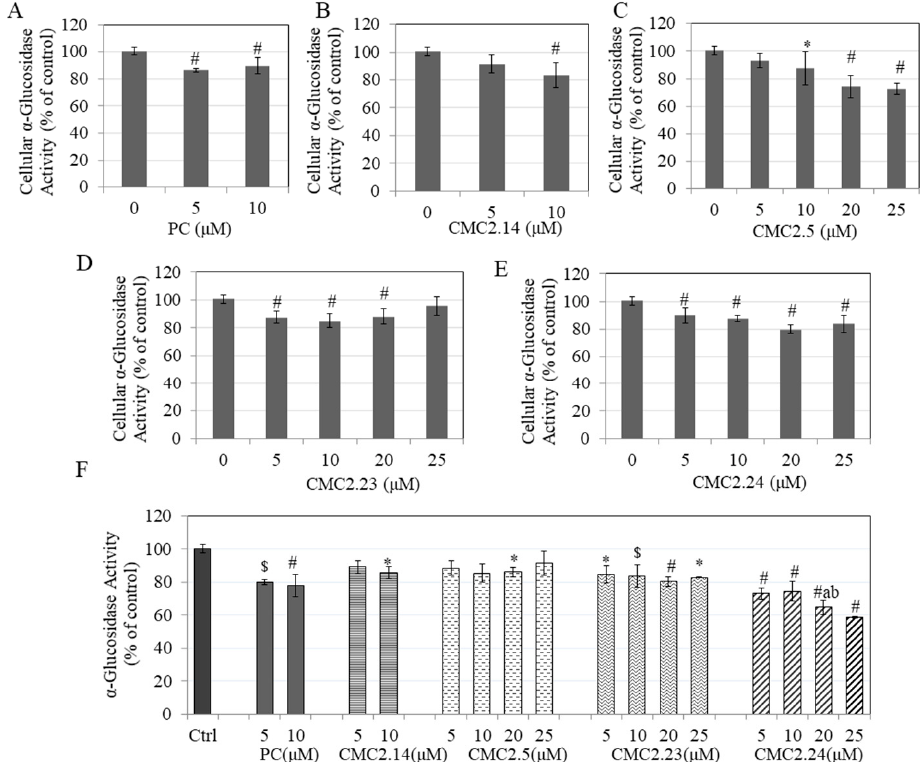
Figure 8. α -glucosidase activity in B16F10 cells treated for 48 h with different concentrations of compounds; ( A ) PC; ( B ) CMC2.14; ( C ) CMC2.5; ( D ) CMC2.23 and; ( E ) CMC2.24; One-way ANOVA with Dunnett’s post hoc test. * p < 0.05 and # p < 0.01 vs. control; Data are combined from at least two independent experiments; ( F ) α -glucosidase activity in cell-free system with different concentrations of PC and CMCs measured using pNG substrate. * p < 0.05; $ p < 0.01 and # p < 0.001 vs. control; letter a— p < 0.05 vs. CMC2.23 (20 µ M); letter b— p < 0.001 vs. CMC2.5 (20 µ M); One-way ANOVA with Tukey’s test; Data are mean ± SD of triplicate